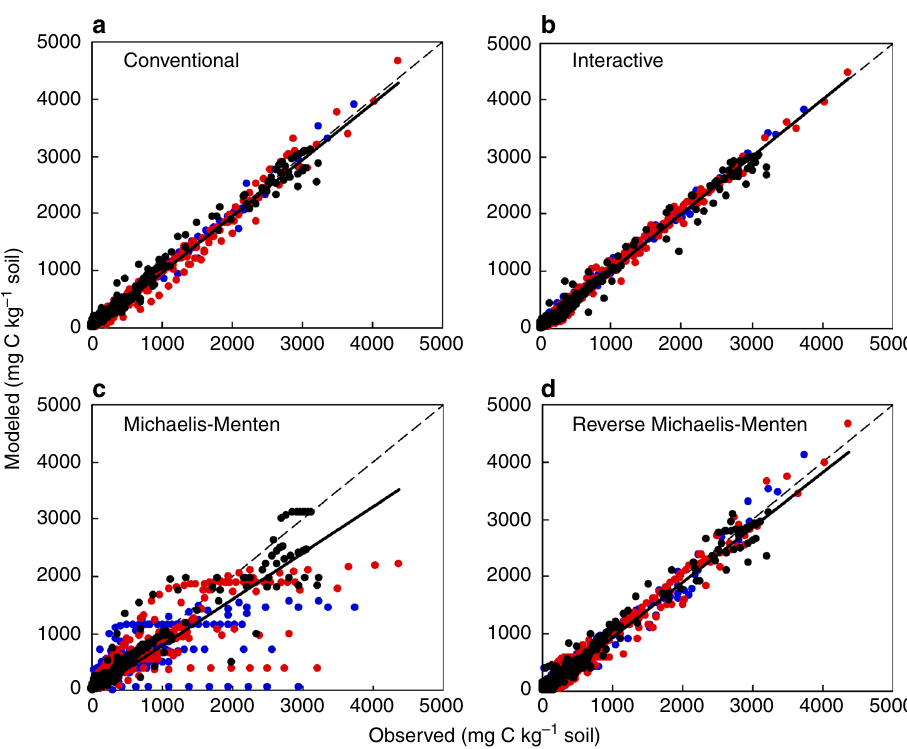
Fig. 4 Within-sample model evaluation. Blue and red dots are CO 2 emissions from old C at the control and new C addition treatments, respectively; Black dots are CO 2 emissions from added new C; Solid line: linear regression (slope, R 2 , P values are shown in Table 1); Dashed line, 1:1 line